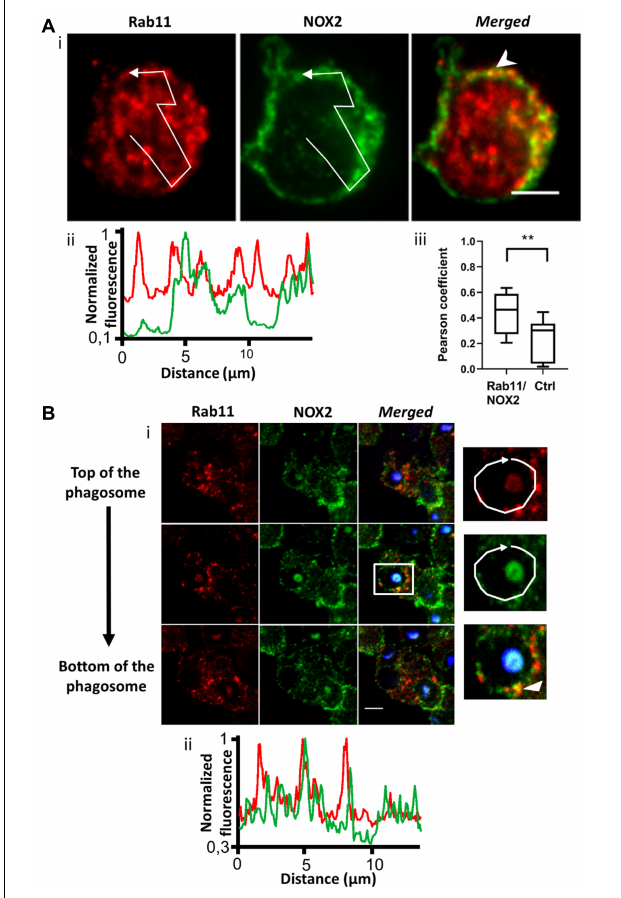
FIGURE 3 | NOX2 is present in some Rab11-positive endosomes that are localized close to the phagosome during phagocytosis. (A) Rab11 (red) and NOX2 (green) were detected by immunofluorescence in resting PLB-985 WT cells using spinning disk confocal microscopy. (Ai) Representative images of single planes from a Z-stack. Scale bar = 3 µ m. Three independent experiments. (Aii) Normalized fluorescence of Rab11 and NOX2 along the white arrow shown in Ai . Overlapping peaks of fluorescence indicate co-localization of NOX2 and Rab11 in the same structures. (Aiii) Co-localization between Rab11 and NOX2 was estimated using the Pearson coefficient (PC) calculated with the JACoP plug-in in Image J. PCs correlating Rab11 and NOX2 images (Rab11/NOX2) were controlled by comparison with the PCs correlating the Rab11 image and the image of NOX2 rotated by 180 ◦ (Control, Ctrl). Eight images were analyzed from three independent experiments. Each boxplot represents the inter-quartile range with the median, ** represents p < 0.01 (Mann Whitney test). (B) Rab11 (red) and NOX2 (green) were detected by immunofluorescence after 10 min of phagocytosis with opsonized Texas Red-zymosan. (Bi) Three planes from a Z-stack series (0.5 µ m). Some Rab11 structures were observed close to or at the phagosomes. Scale bar = 3 µ m. Three independent experiments. (Bii) Normalized fluorescence of Rab11 and NOX2 along the white arrow showing some overlapping peaks at the phagosome.